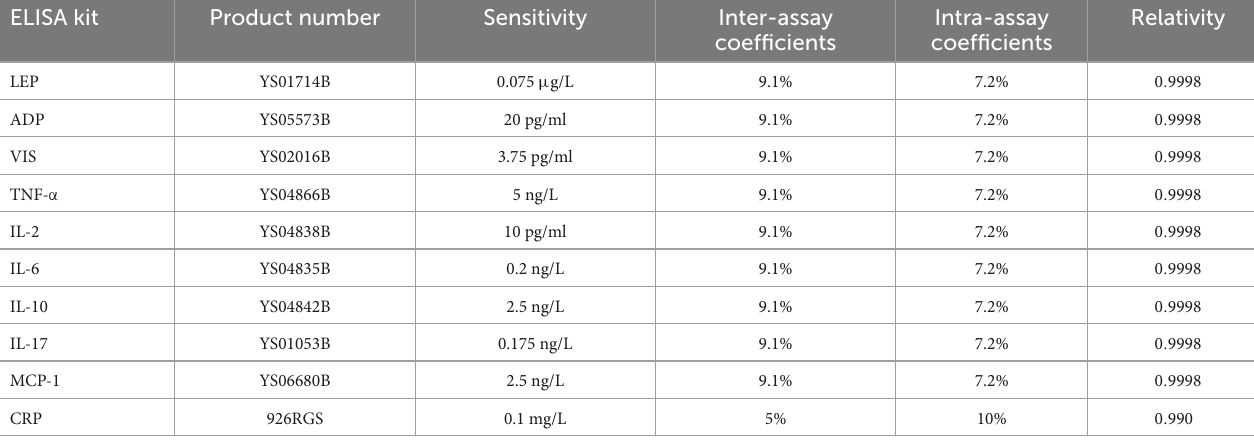
TABLE 1 The product number, sensitivity, intra- and inter-assay coefficients, and relativity of the ELISA kits. ELISA kit